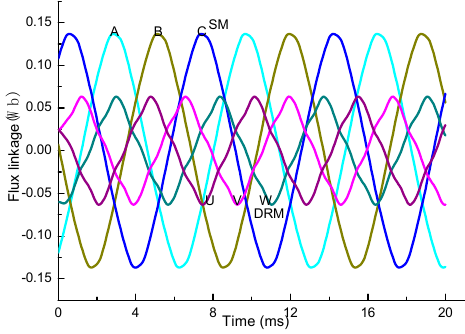
Figure 16. Flux linkage of stator and inner rotor windings.